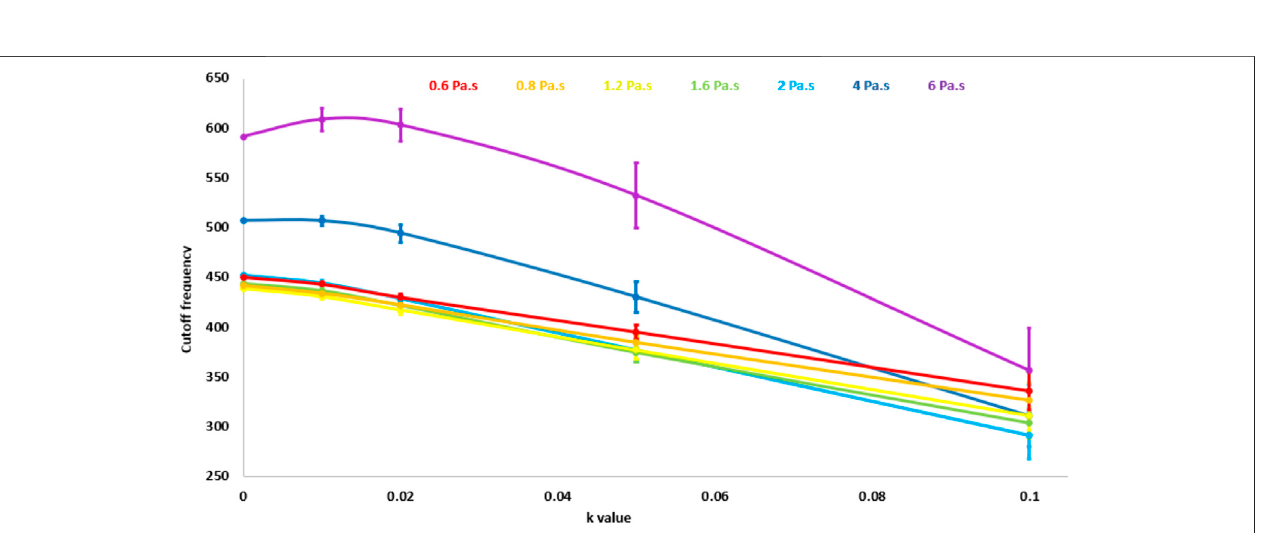
Frontiers in Physics |